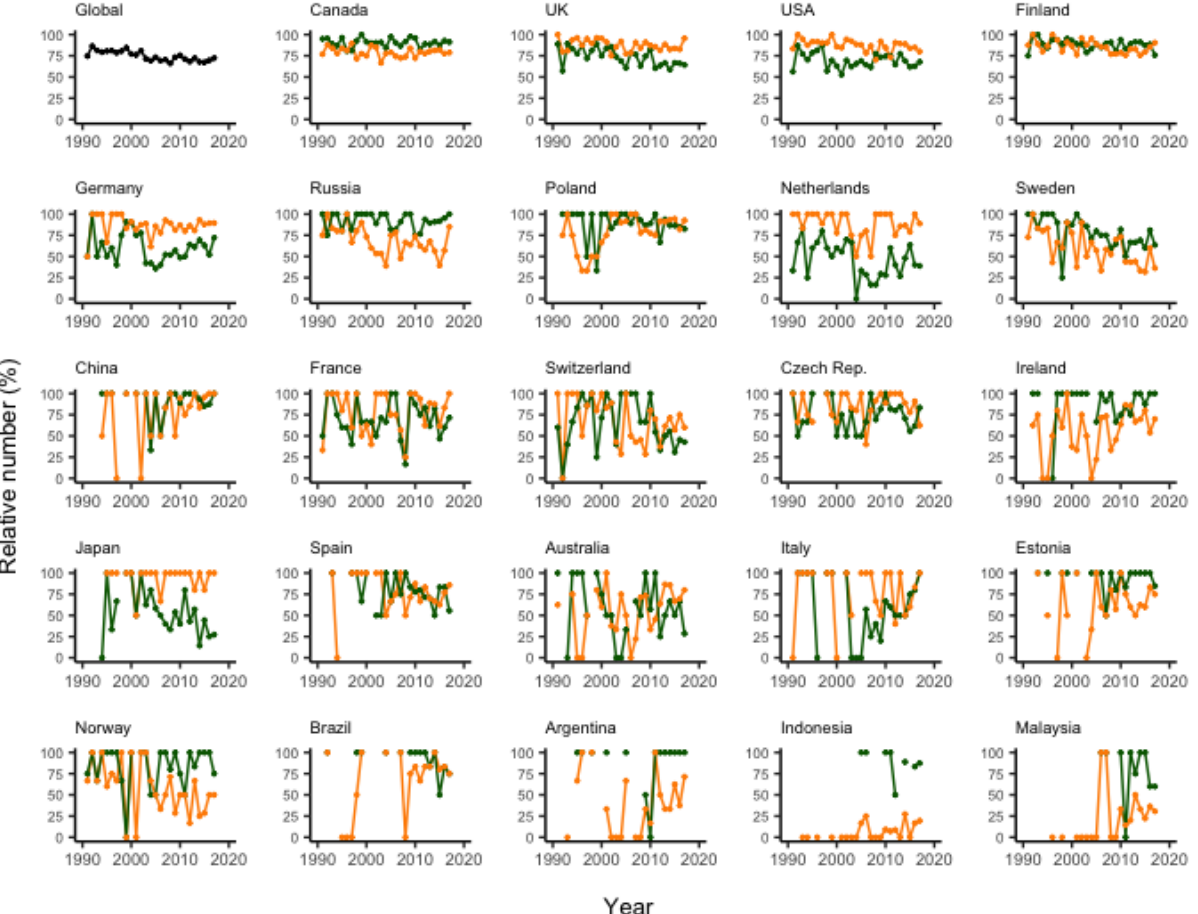
Figure 6. Relative number of articles whose first author is from country X that study peatlands in country X (green), and of peatlands in country X studied in articles from country X (orange). The global panel shows the total proportion of domestic studies. Countries are ordered according to the total number of